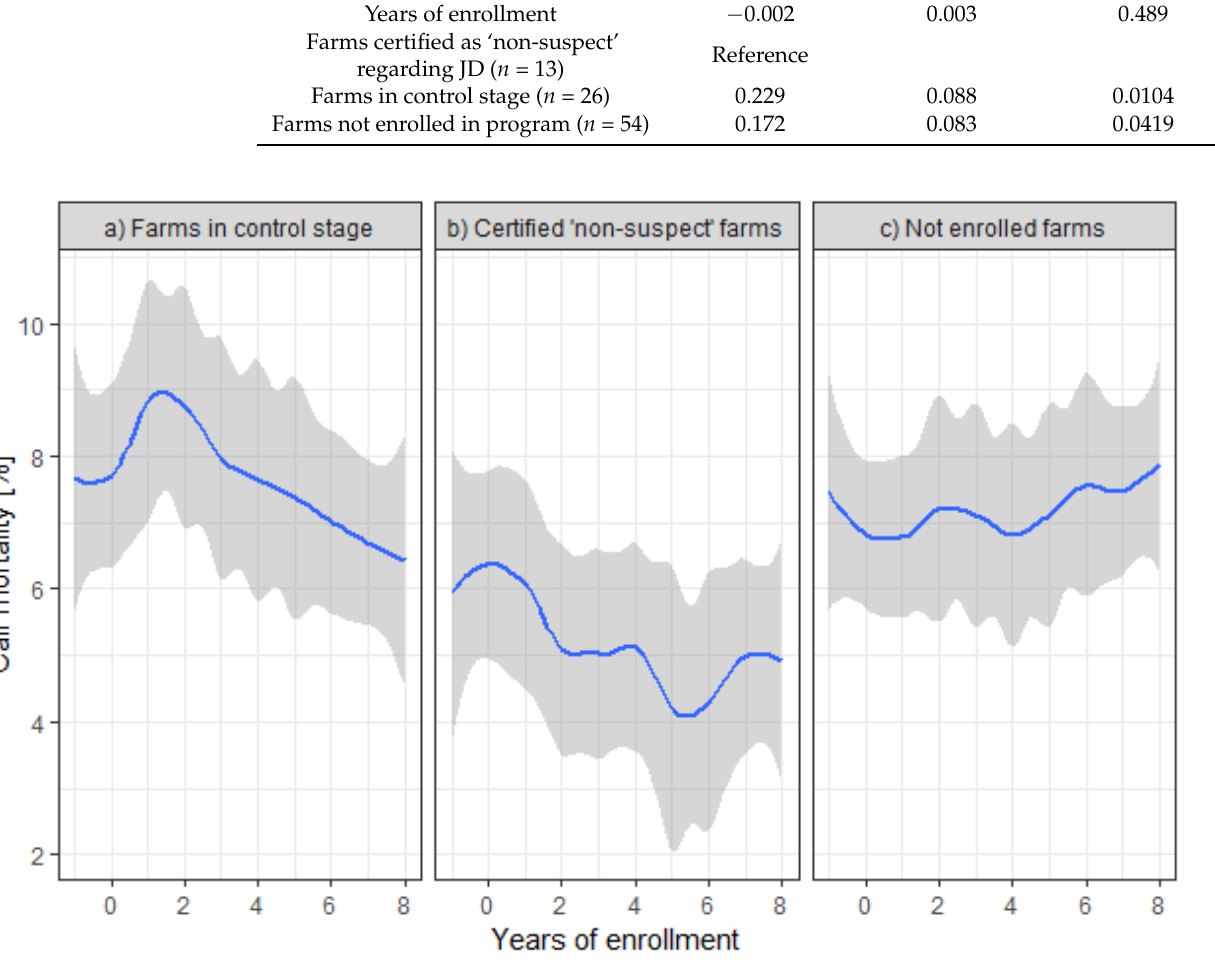
11 of 20 Table 2. Results of the generalized linear mixed-effects model for variables associated with calf mor- tality. Fixed effects